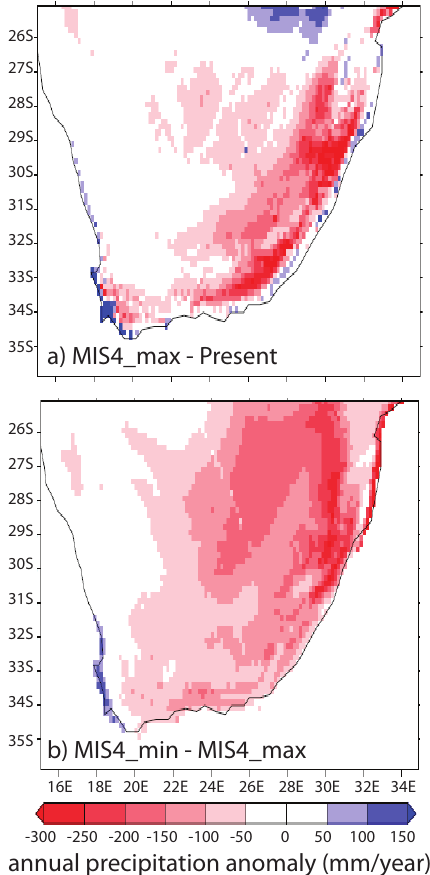
Figure 8. Annual precipitation (mmyr − 1 ) simulated by IPSL_CM5A and downscaled to 0.16 ◦ for (a) MIS4_max–present, and (b)